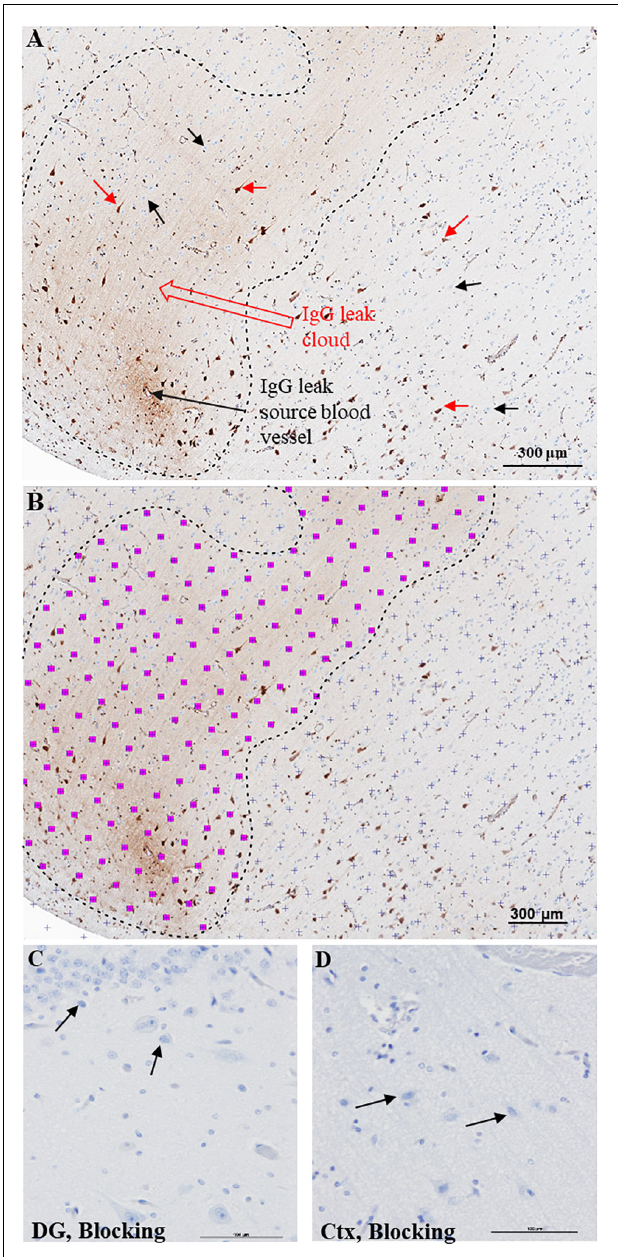
FIGURE 1 | Semi-quantitative approach to quantify BBB breach extent. (A) Bright field DAB image of cerebral cortex demonstrating extravasation of IgGs from a leaky blood vessel. The IgG leak forms a characteristic ‘leak cloud’ marked between black dotted lines. Certain pyramidal neurons located within and outside the leak cloud display selective immunoreactivity for IgGs (red arrows), while a larger number of pyramidal neurons fail to show IgG immunoreactivity (black arrows). (B) Processed image to measure selective IgG immunoreactivity area using Cavalieri estimator function of stereology software grid system to define non-immunoreactive areas of tissue (purple + marks) and immunoreactive areas (pink squares with purple + marks). This software estimates IgG leak fraction for each section. Scale bar = 300 µ m. Hippocampal (C) and cortical (D) regions from a control slide probed with only 2% blocking serum and ABC reagent. DG = dentate gyrus, Ctx = Temporal cortex, Scale bar = 100 µ